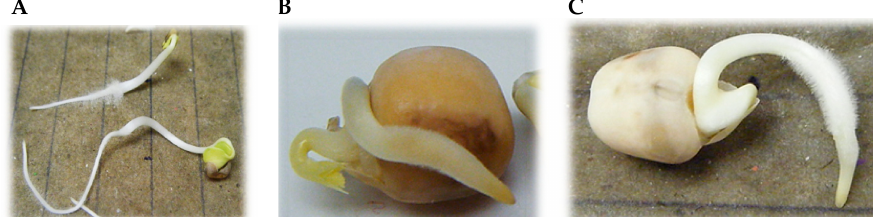
Figure 3. ( A ) Damage observed in R. sativus seedlings exposed 5 days to RB5 treated T. maxima LE130 cultures; ( B ) P. sativum seedlings after being exposed 5 days to the LE130-treated dye; ( C ) P. sativum seedling exposed to CV treated with Trametes sp LA1 (LA1-treated